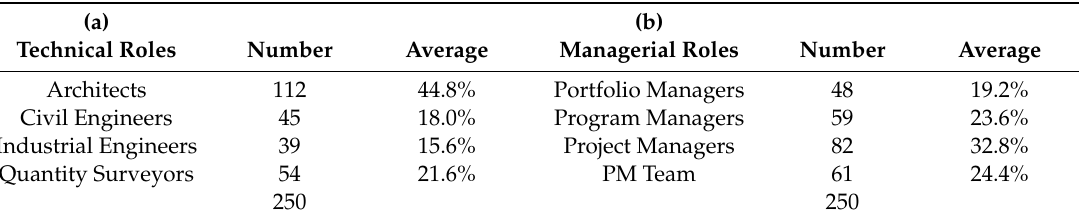
Table 8. Technical (a) and managerial (b) roles of the